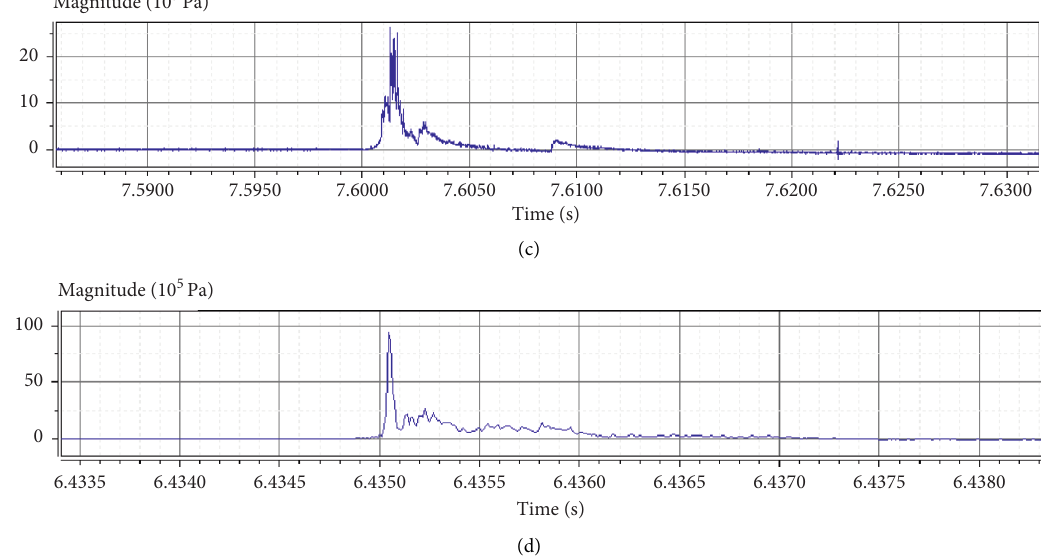
Figure 7: Waveforms of stress in different positions of CO waveform of measuring point B (6.6MPa). (c) The waveform of measuring point C (2.6MPa). (d) The waveform of measuring point D